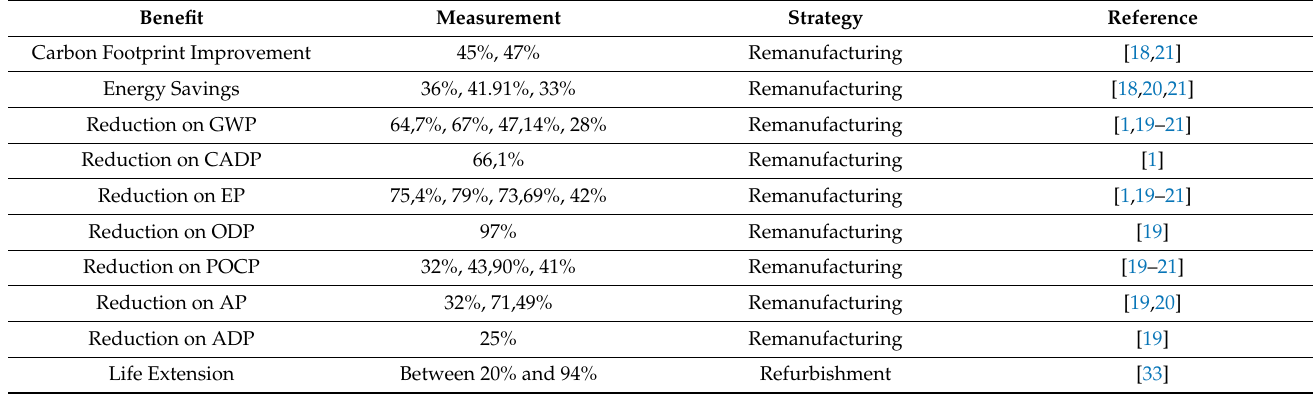
Table 3. Recap on the more relevant measured